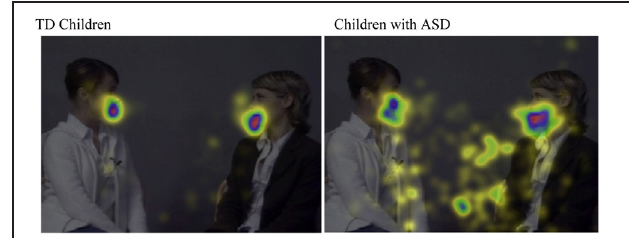
FIGURE 2 | The mean relative duration of fixations on the different parts of the display during the conversation. The durations of fixation are calculated from a group of TD 3-years-old children ( n = 12) and a group of 3–6-years-old children with ASD ( n = 9). The increasing amount of fixations on a specific part of the display is depicted in yellow-green-blue-red color where red corresponds to the most fixations. It can be seen that the fixations of the children with ASD are more scattered than the fixations of the TD children. In addition, the fixation highlights show that the children with ASD have a strong tendency to fixate the shadow casted by the right model. When she spoke, she tended to move her head a little and the shadow of her head attracted the gaze of the children with autism but not the TD children (From von Hofsten et al., 2009, RASD, by